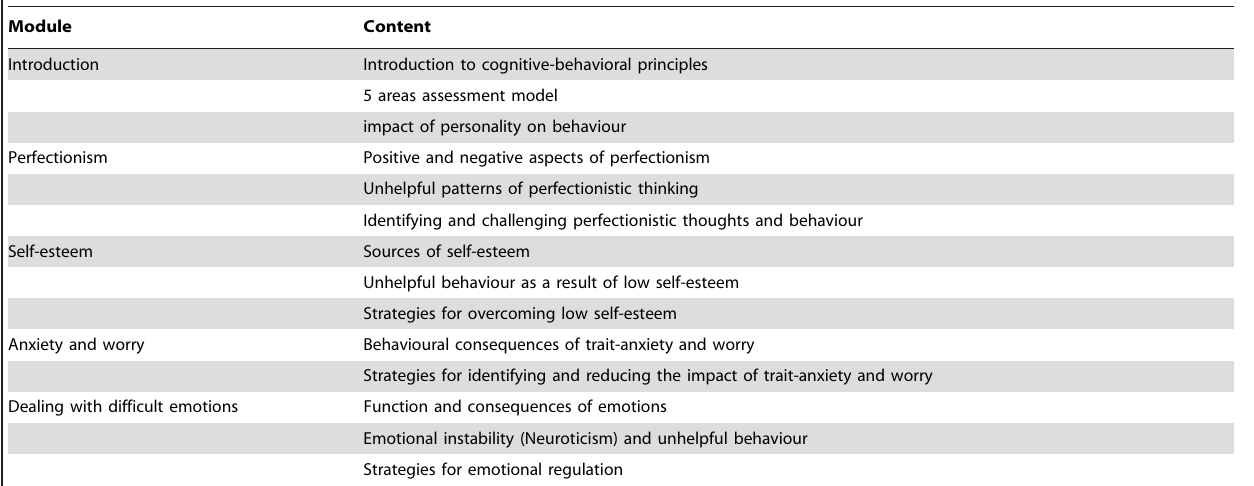
Table 1. Outline of trait-focused intervention content.